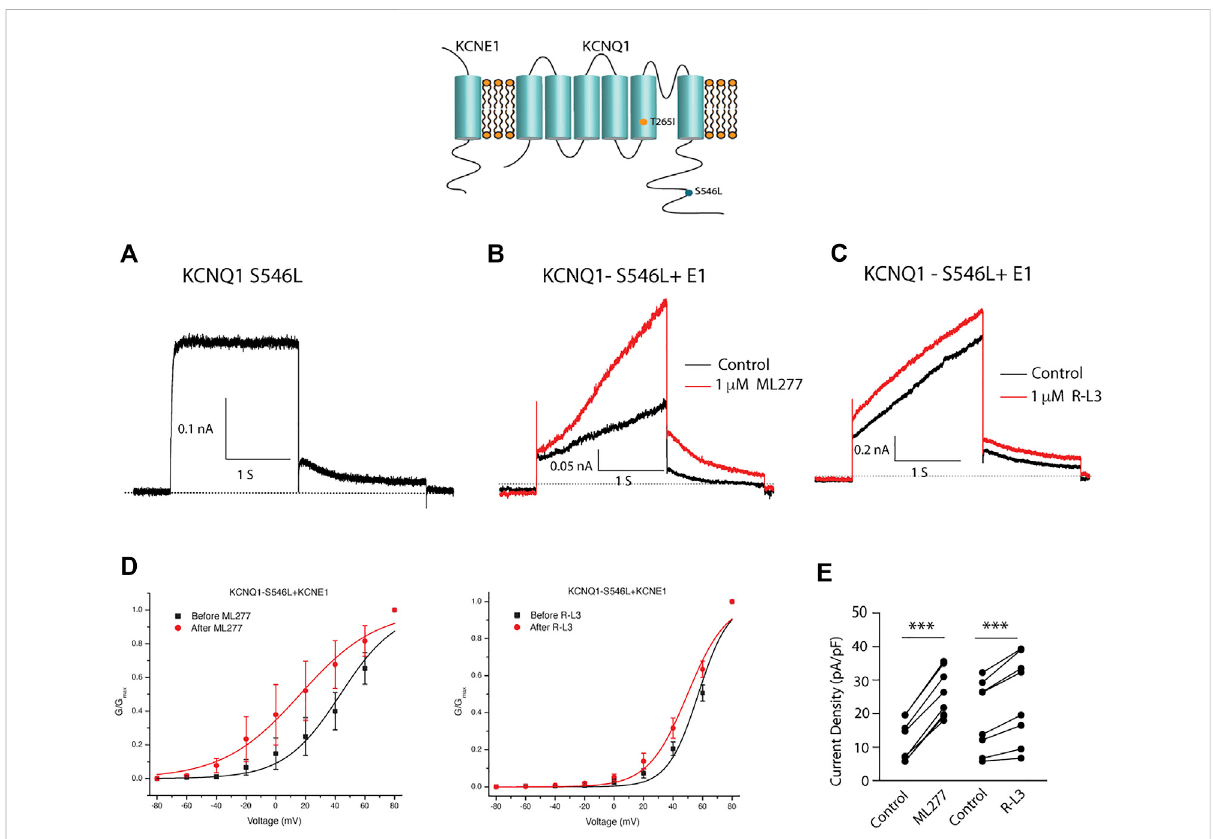
FIGURE 8 Select LQT-1 mutant channel currents are augmented by ML277 and R-L3. (A) . Cells were transfected with KCNQ1-S546L without KCNE1. (B) . KCNQ1-S546L-KCNE1 channel activity measured at +60 mV in the absence (boack) and presence (red) of 1 µM ML277. (C) . KCNQ1-S546L- KCNE1 channel activity measured at +60 mV in the absence (boack) and presence (red) of 1 μ M R-L3. (D) . Normalized conductance/voltage curves measured in the absence (black curves) and presence (red curves) of 1 μ M ML 277 (left panel) or RL-3 (right panel). (E) Summary data for peak currents measured after 2 s depolarization to +60 mV in the absence (control) and presence of 1 µM ML277 or 1 μ M R-L3 with straight lines joining recordings for individual